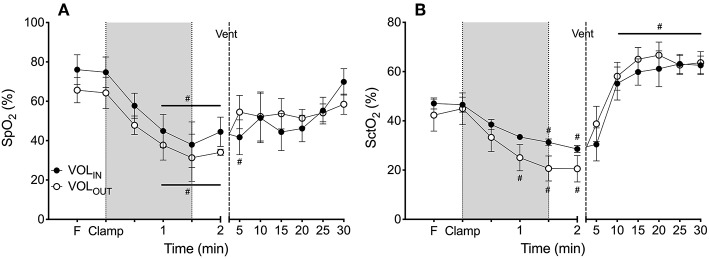
Arterial and cerebral oxygenation. (A) Mean systemic arterial oxygen saturation (SpO2) and (B) mean cerebral tissue oxygenation (SctO2) measured in VOLIN (closed circles) and VOLOUT (open circles) preterm lambs throughout the study. # indicates significant difference from fetal value (p < 0.05).